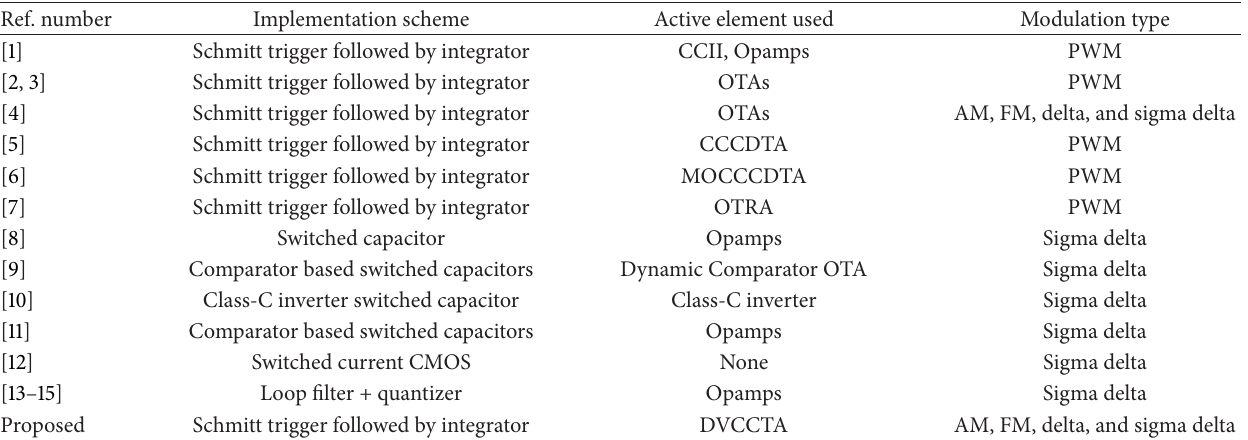
Table 1: Comparison of exiting modulator topologies.